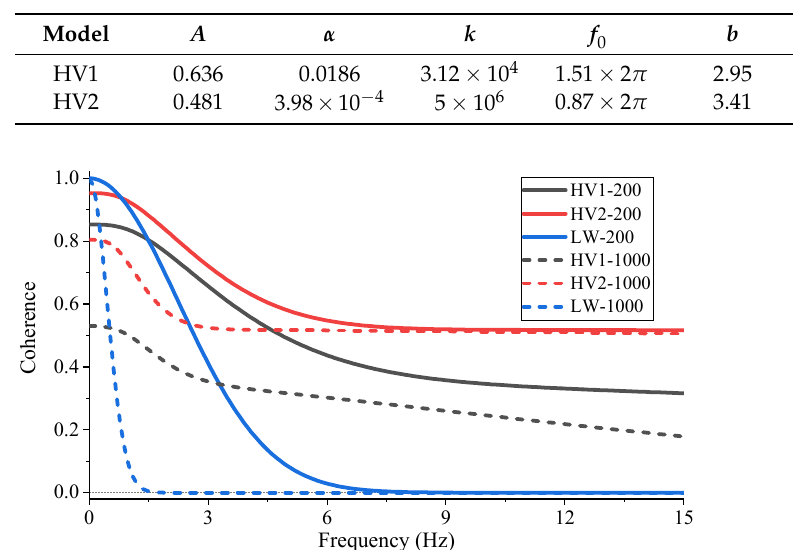
Table 2. Parameter settings for the HV spectral coherence model.